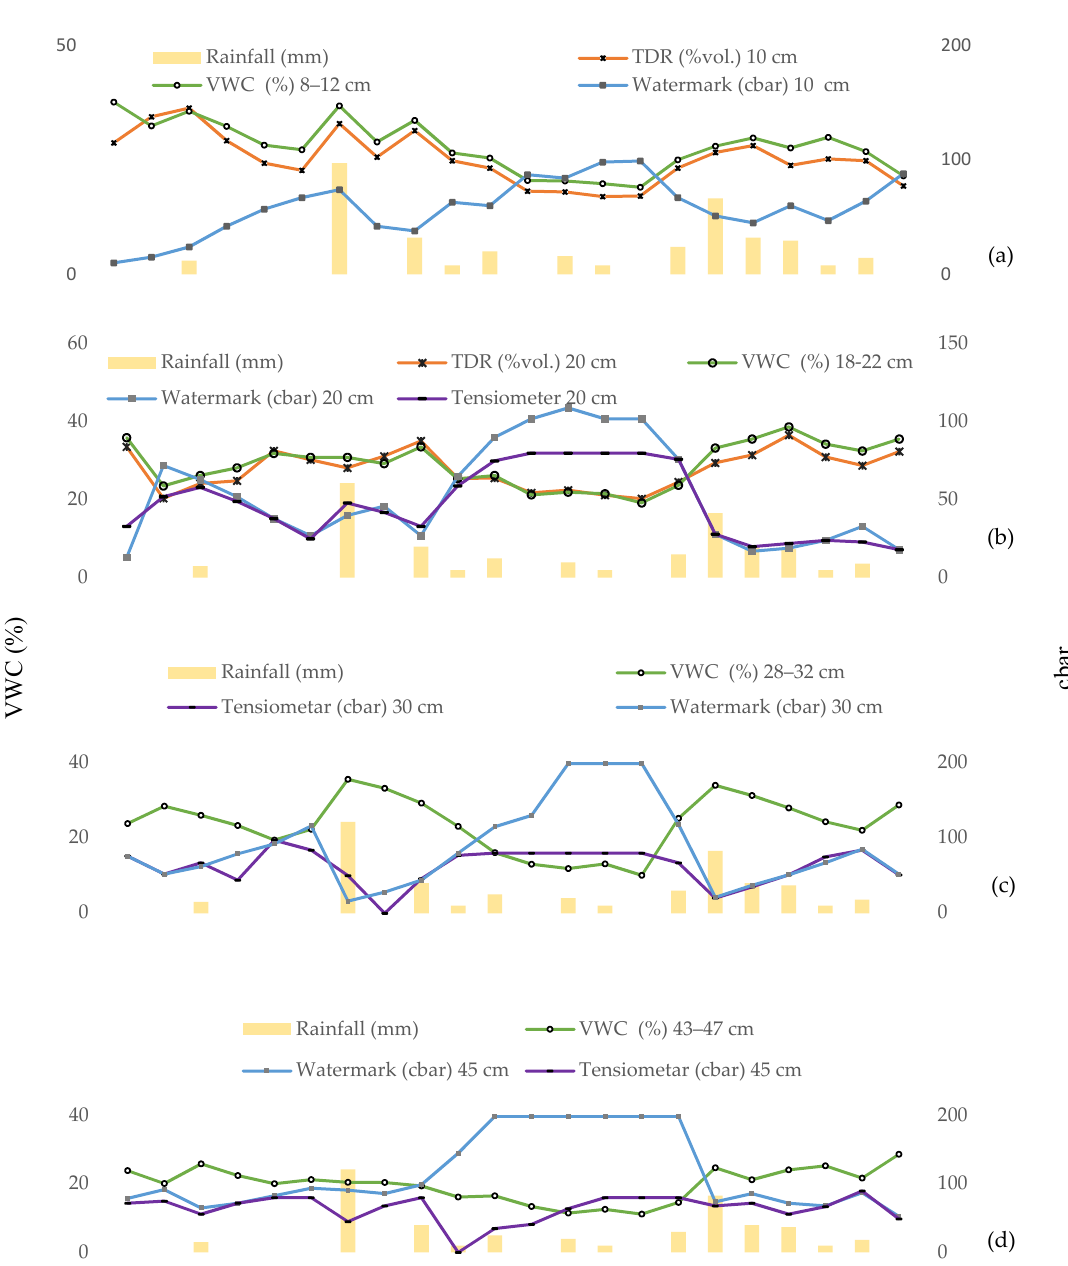
Figure 5. Amount of rainfall (mm) and soil water content (Volumetric Water Content (VWC) (%), cbar) at 10 ( a ), 20 ( b ), 30 ( c ) and 45 cm ( d ).